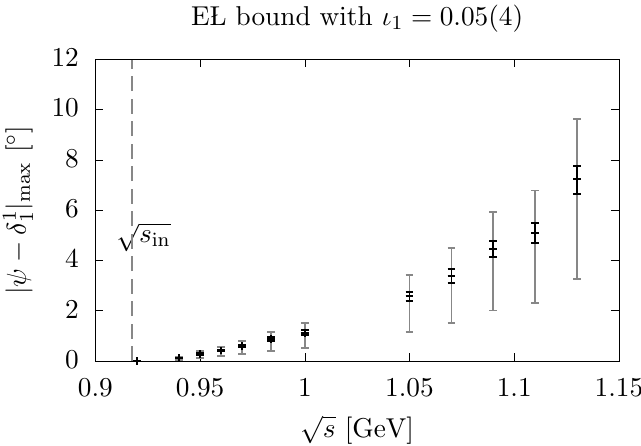
Figure 2. E L bound on the di(cid:11)erence between the phases of the pion VFF and the elastic (cid:25)(cid:25) P -wave. The bound uses the data compilation of [118] for the cross section ratio r , and an elasticity parameter calculated with (cid:19) 1 = 0 : 05(4). The smaller black error bars indicate the uncertainty due to r , the larger gray error bars the uncertainty due to (cid:19) 1